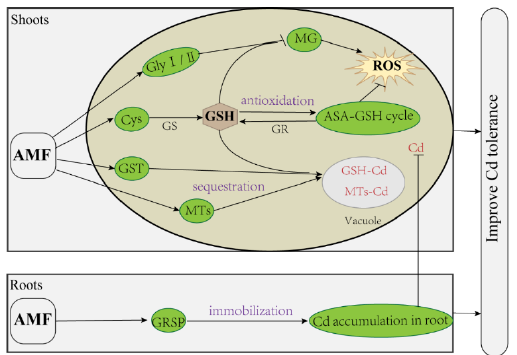
Figure 10. The proposed regulatory mechanism model of AMF to alleviate Cd stress in wheat. Arrow and bar ends indicate activation and inhibitory effects, respectively. AMF: arbuscular mycor- rhizal fungi; Gly I/II glyoxalase I/II; MG: methylglyoxal; Cys: cysteine; GS: glutathione synthase; GSH: glutathione; GR: glutathione reductase; AsA-GSH cycle: ascorbate-glutathione cycle; GST: glutathione S-transferase; MTs: metallothionein; ROS: reactive oxygen species; GRPS: glomalin related soil